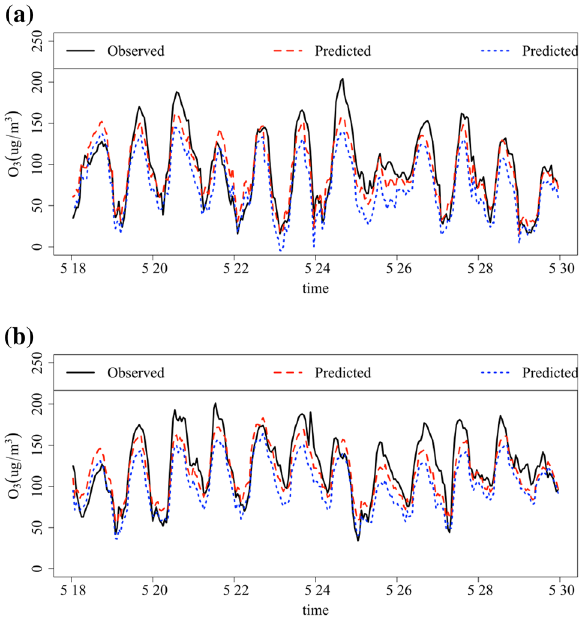
Fig. 7 Actual observed and model-predicted concentrations of ozone in Anqing ( a ) and Fuyang ( b ) during pollution events. The red dashed line represents the prediction using the original data. The blue dashed line represents the prediction for the scenario with a 50% decrease in the ELE14